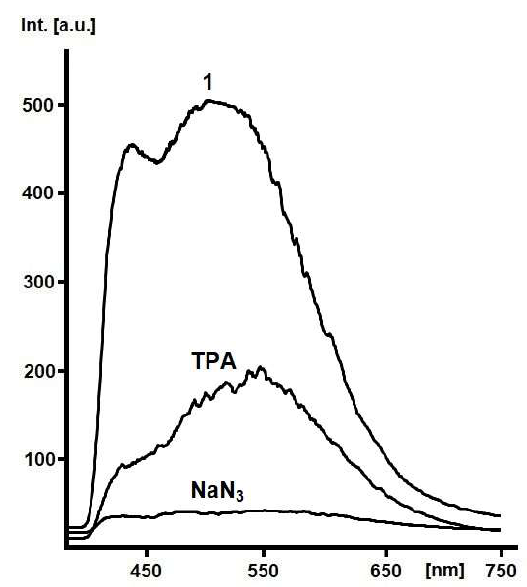
Figure 4. The emission spectra of solid samples of the Cd6 complex 1 , free Tris(2-methylpyridyl)amine (TPA) and NaN 3 (λ ex = 366 nm). 2. Synthesis of [Cd 6 (TPA) 4 (μ 3 -1,1,3-N 3 ) 4 (μ 2 -1,1-N 3 ) 6 ](ClO 4 ) 2 ·2H 2 O (1) An aqueous solution of NaN 3 (0.065 g, 1 mmol in 10 mL H 2 O) was added to a mixture containing equimolar amounts of Cd(ClO 4 ) 2 ·6H 2 O (0.210 g, 0.5 mmol) and TPA (0.145 g, 0.5 mmol)